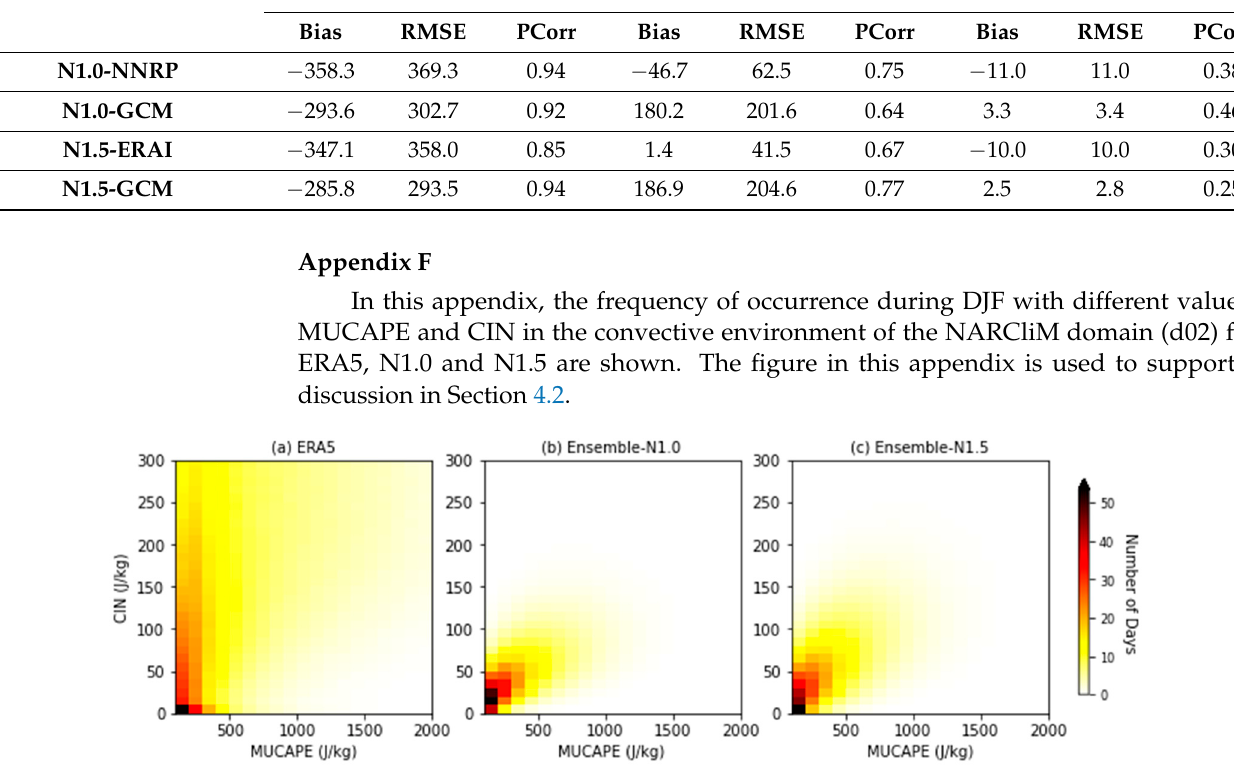
Figure A21. Two-dimensional histogram of MUCAPE vs. CIN for all land grid points in d02 during DJF. The frequencies have been scaled as equivalent to number of days in a season.